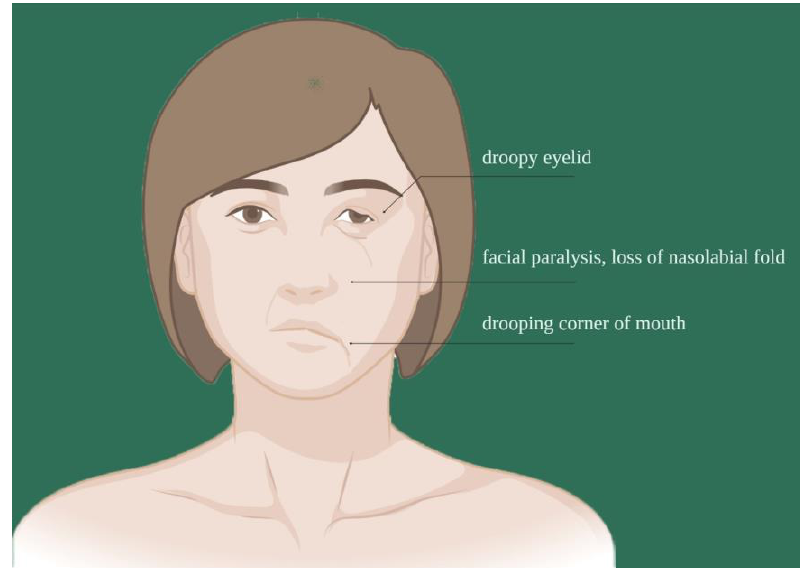
Figure 1. Bell’s palsy is a unilateral facial peripheral palsy of the facial nerve that results in muscle weakness on one side of the face affected. The drawing shows the typical aspect and consequences of a patient affected by it. Image created with BioRender.com .